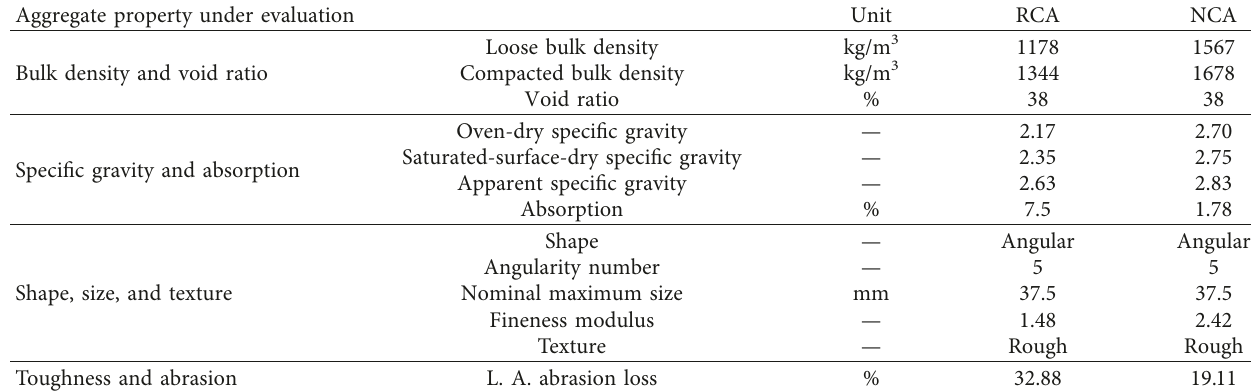
Table 3: Results obtained in characterization of the RCA and NCA.